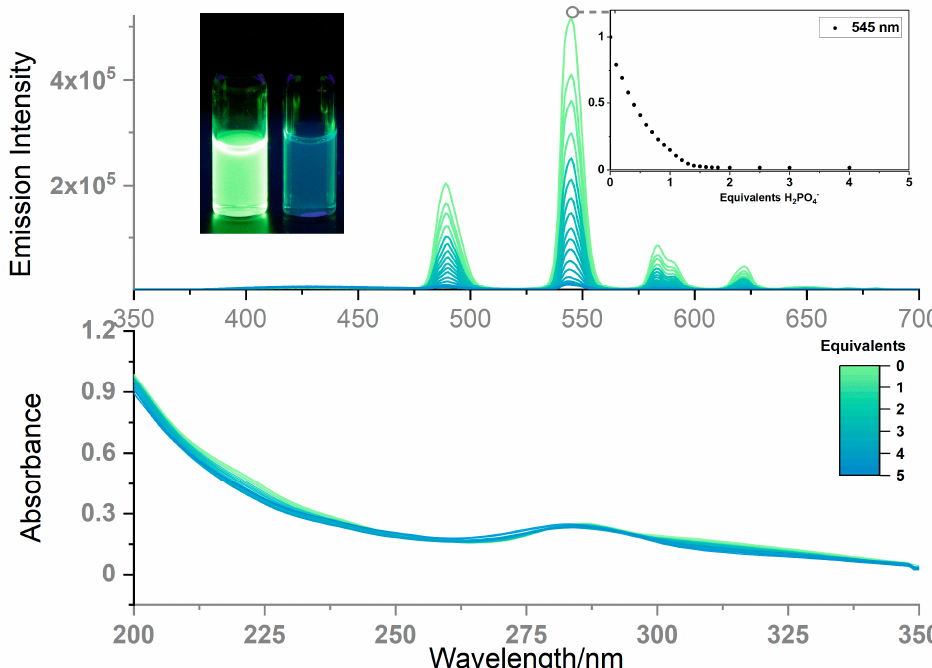
Figure 4. Top panel: 0.9 mM of [Tb. 1] (OTf) 3 in the absence (left) and presence (right) of H 2 PO 4 − (10 equivalents). Spectra resulting from the titration of[ Tb. 1] (OTf) 3 (9.9 µM, acetonitrile) with 0 to 7 equivalents of H 2 PO 4 − . Fluorescence (top panel) and UV-vis (bottom panel). The binding isotherm for the emission intensity at 545 nm in the fluorescence spectrum is shown as an inset in the top panel.